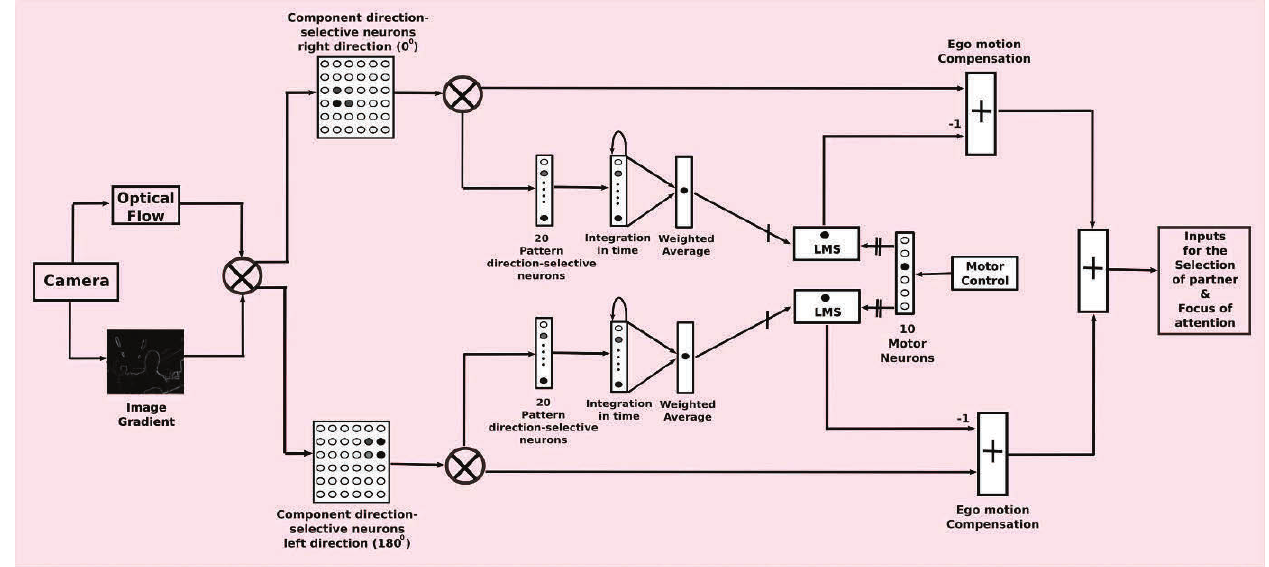
Figure 13. Architecture for a mobile